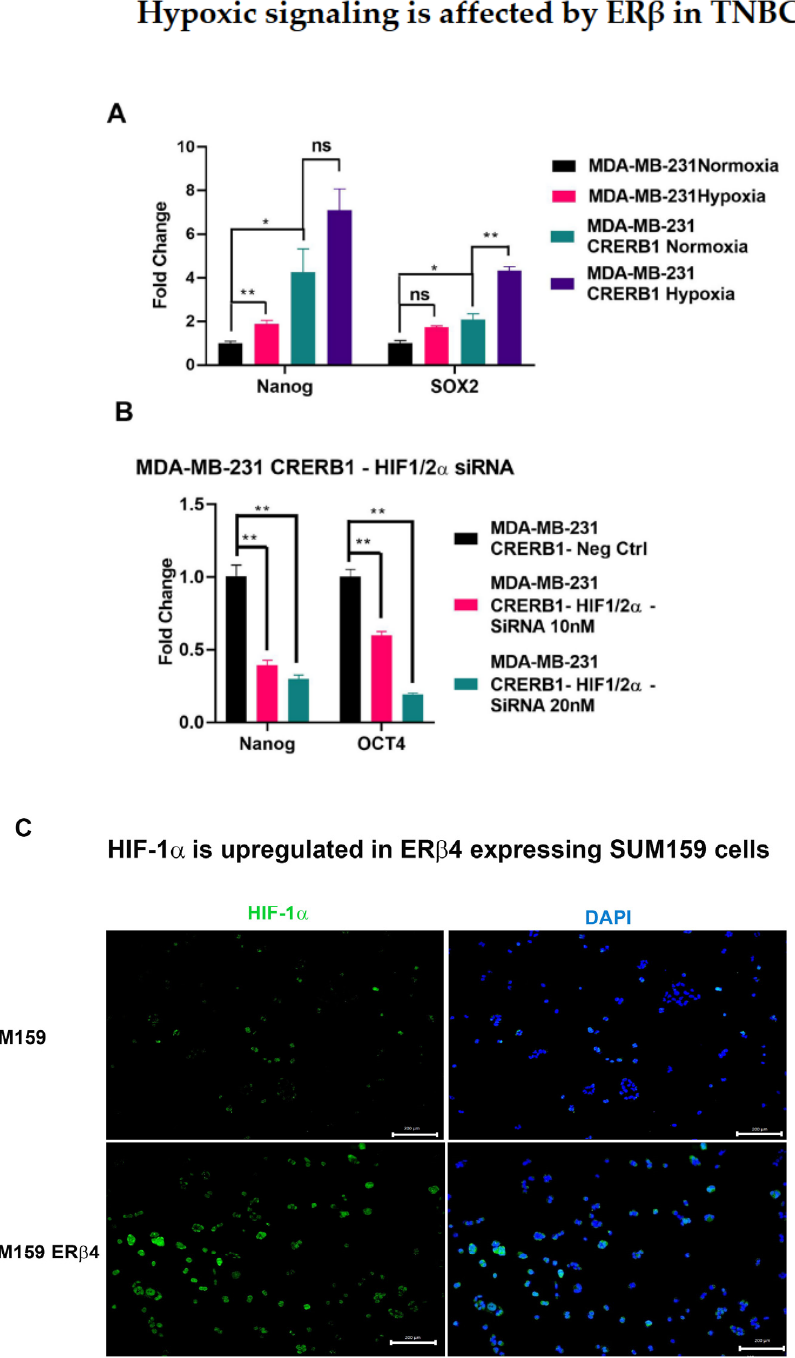
Figure 6. ( A ). qRT-PCR analysis of stem cell markers Nanog, Oct4 and SOX2 expression levels after subjecting MDA-MB-231 WT or CRERB1 cells to normoxia or hypoxia (1% O 2 for 4 h). All results are shown as mean ± s.e.m. from three technical replicates. Data was analyzed using unpaired Two- tailed Student’s t -test. p -values: * p < 0.05, ** p < 0.01 and ns = non-significant. ( B ). MDA-MB-231 CRERB1 cells transfected with control siRNA and siRNA to both HIF-1 α and HIF-2 α and analyzed